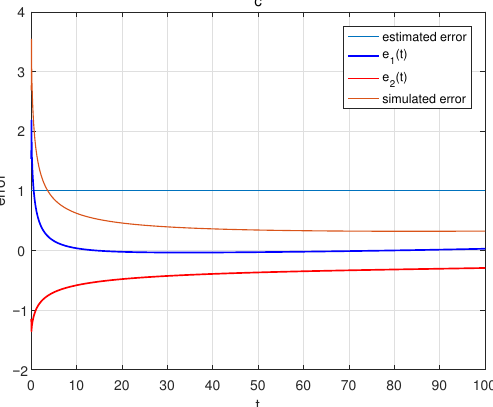
Figure 3. The state of error system when β 1 = 1.5, β 2 = 1, g 1 = 2, g 2 =